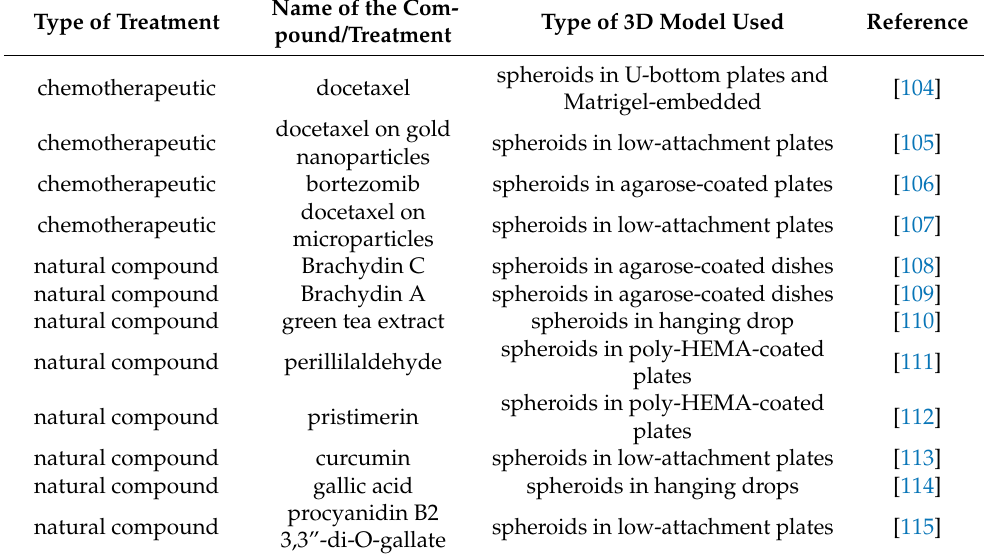
Table 1. Recent examples of the use of 3D in vitro models for testing of various compounds and